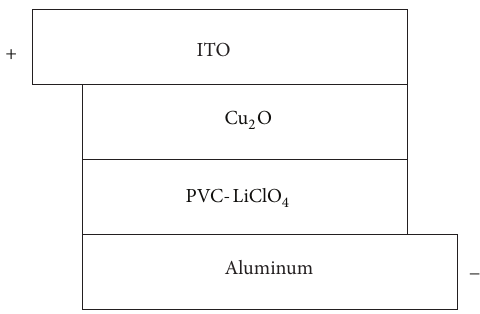
Figure 4: Layer of PESC of ITO/Cu 2 O/PVC-LiClO 4 /aluminum.